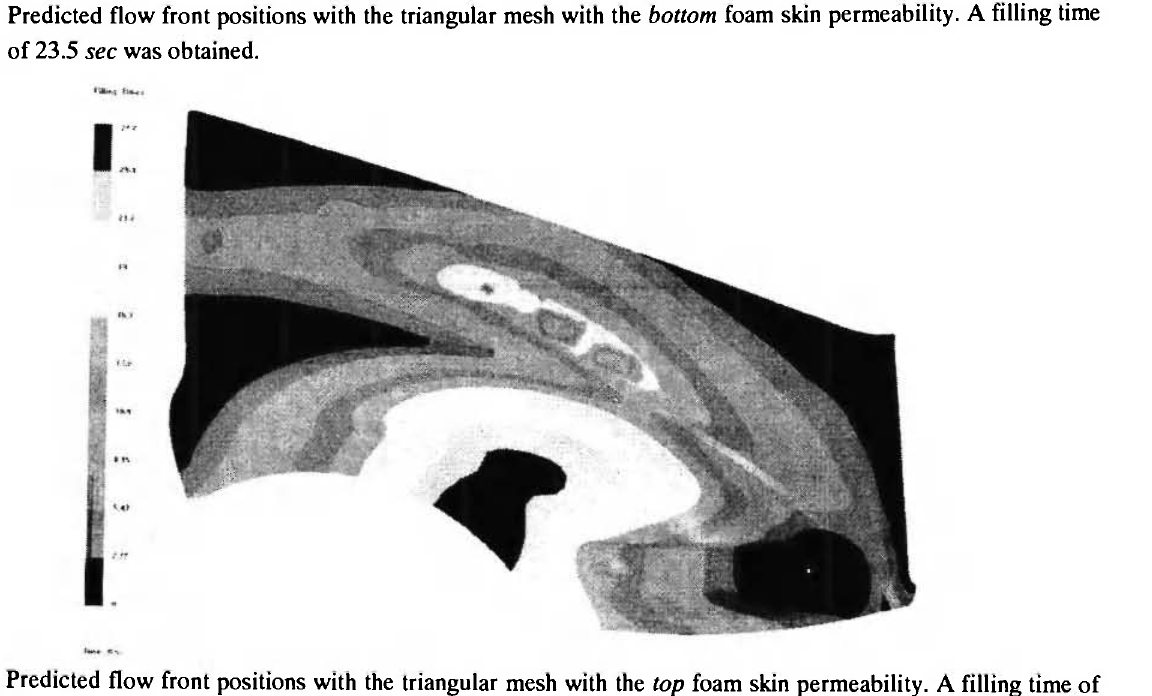
Fig. 26: Predicted flow front positions with the triangular mesh with the top foam skin permeability. A filling time of 27.2 sec was calculated.